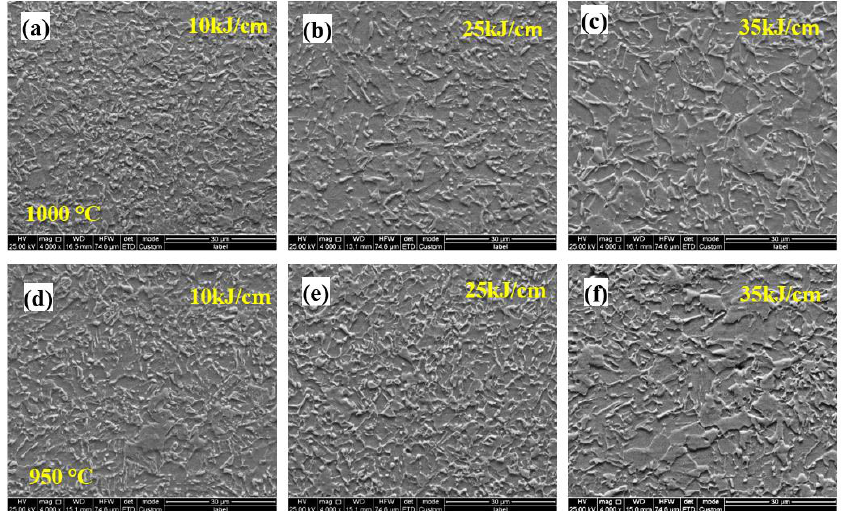
Figure 10. Microstructure of FGHAZ with 0.112Nb content under various heat input and peak tem- perature: ( a ) 10 kJ/cm at 1000 °C; ( b ) 25 kJ/cm at 1000 °C; ( c ) 30 kJ/cm at 1000 °C; ( d ) 10 kJ/cm at 950 ◦ C; ( b ) 25 kJ/cm at 1000 ◦ C; ( c ) 30 kJ/cm at 1000 ◦ C; ( d ) 10 kJ/cm °C; ( e ) 25 kJ/cm at 950 °C; ( f ) 30 kJ/cm at 950 °C. temperature: ( a ) 10 kJ/cm at 1000 at 950 ◦ C; ( e ) 25 kJ/cm at 950 ◦ C; ( f ) 30 kJ/cm at 950 ◦